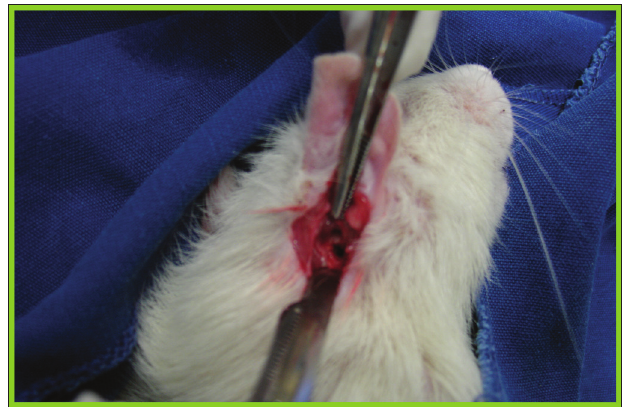
Figure 3. Bone defect creation on the mastoid which will be filled out by